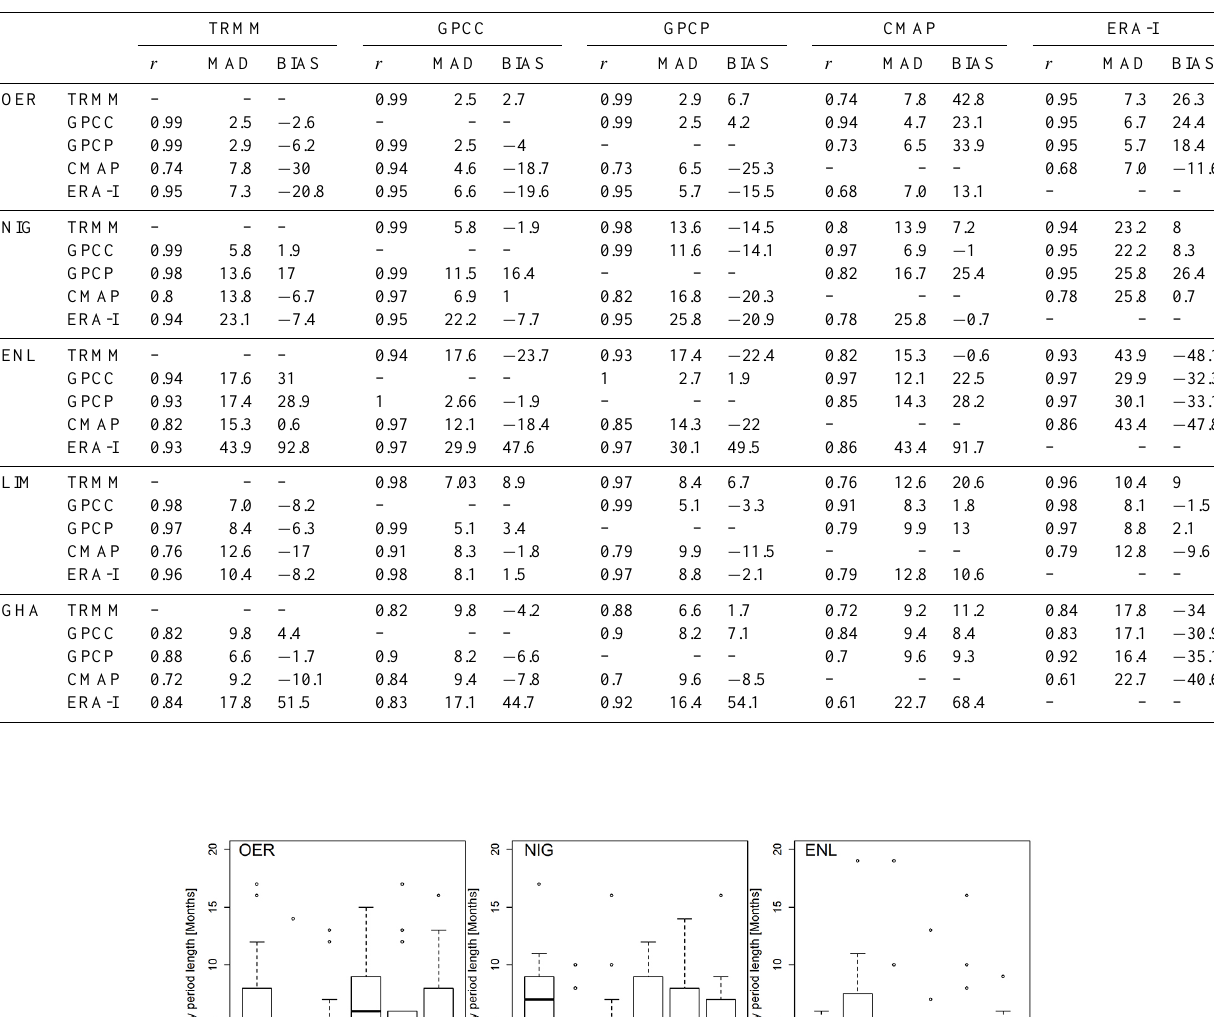
Table 3. Correlation coefficient ( r ), mean absolute difference (MAD) and percentage bias (%) between the different precipitation data sets averaged over each region for the common period 1998–2010. All correlations are significant at 99%.